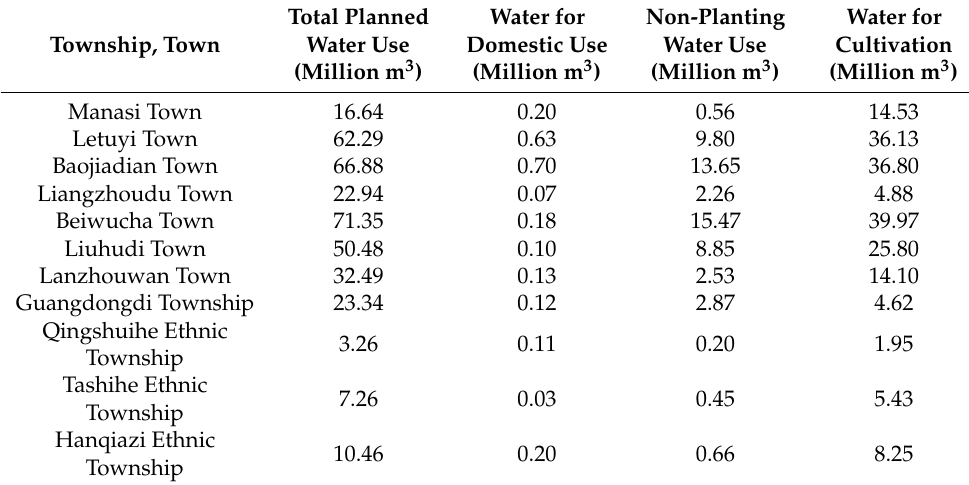
Table 4. Water consumption of townships in Manas